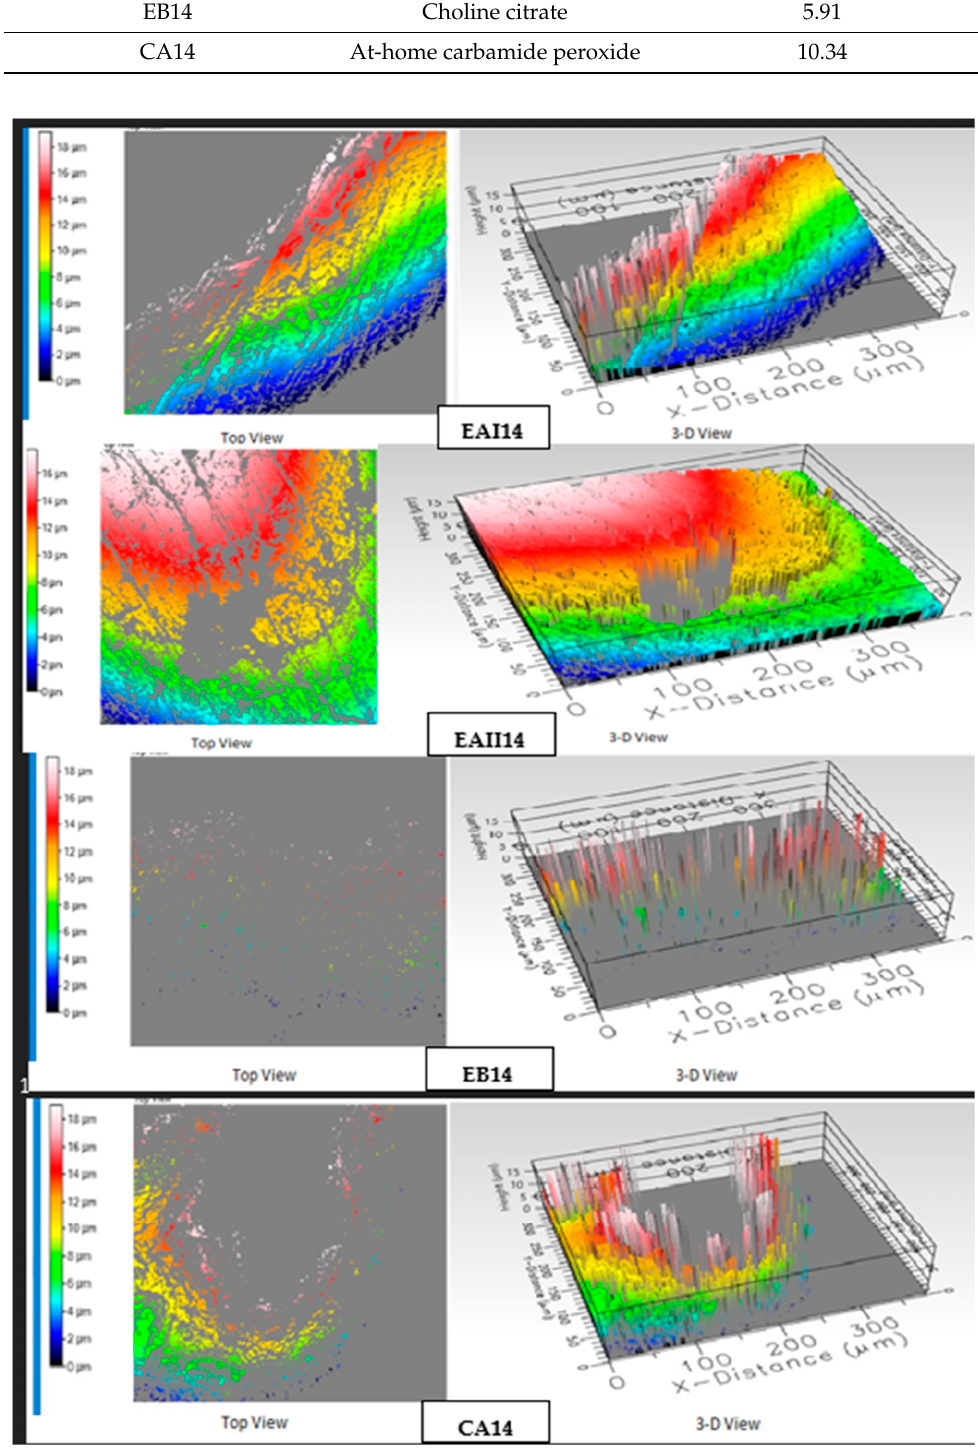
Figure 10. Top and 3D surface topography of the EAI14, EAII14, EB14, and CA14 groups .